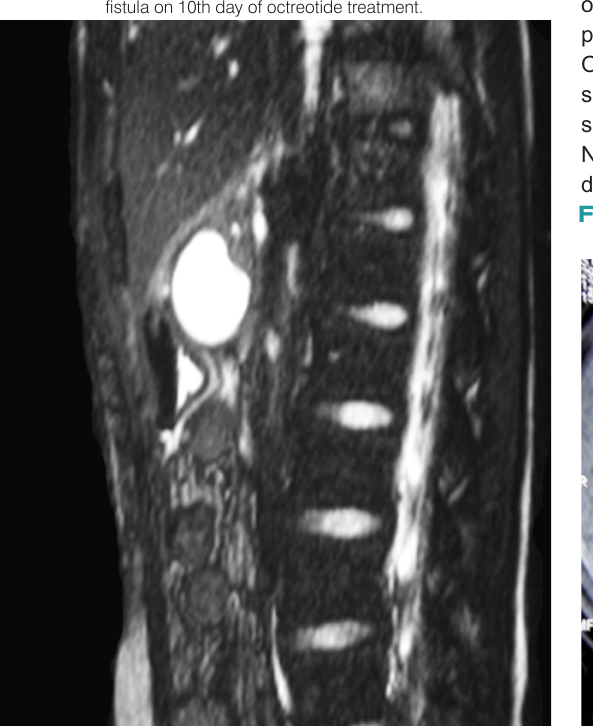
Figure 2. Magnetic resonance showing pancreatic pseudocyst in the pancreatic body and closed percutaneous pancreatic fistula on 10th day of octreotide treatment.